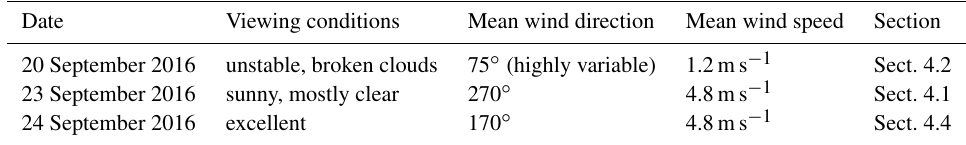
Table 1. Meteorological conditions during the example days focused on in the respective